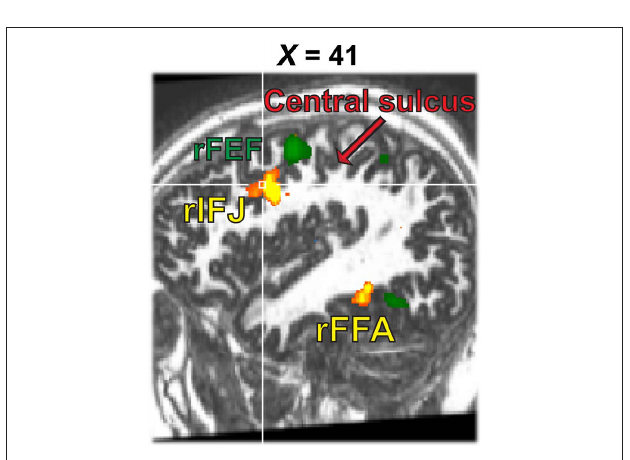
FIguRe 5 | Activation map from the 1-back task (yellow, faces–tools, p < 0.0001, t > 5.30) overlaid onto the activation map from the eye movement localizer (green, eye movements-fixation, p < 0.0001, t >